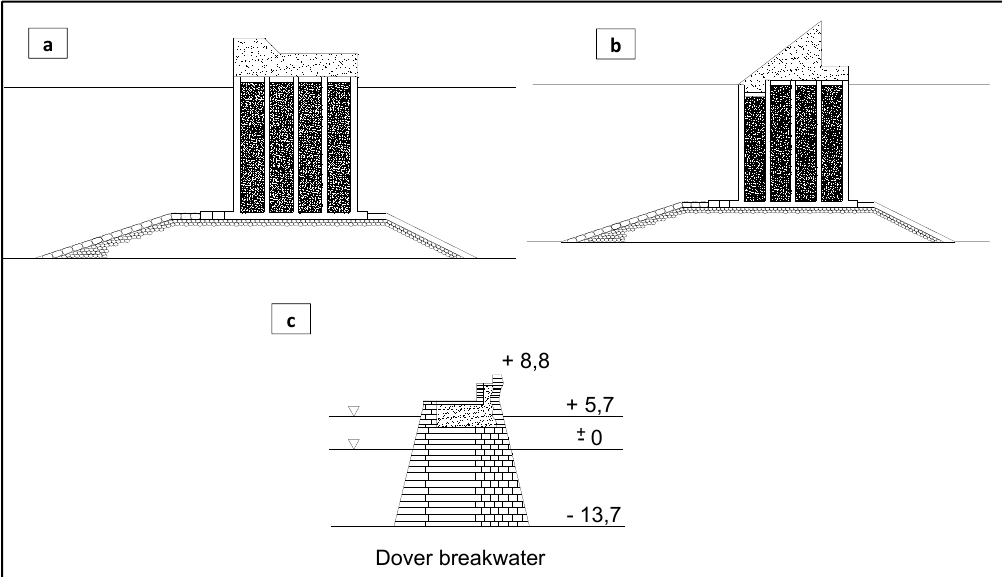
Figure 5. Examples of monolithic maritime dikes: ( a ) Vertical breakwater. ( b ) Sloping top caisson. ( c ) Trapezoidal